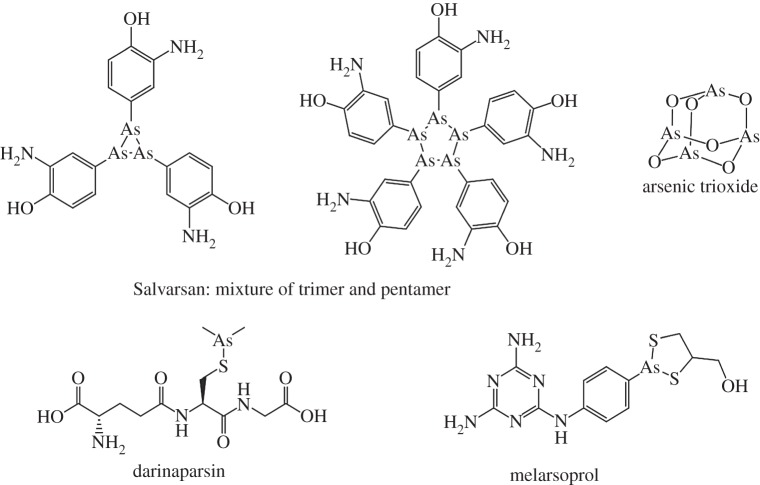
Structures of arsenic-containing drugs [370].